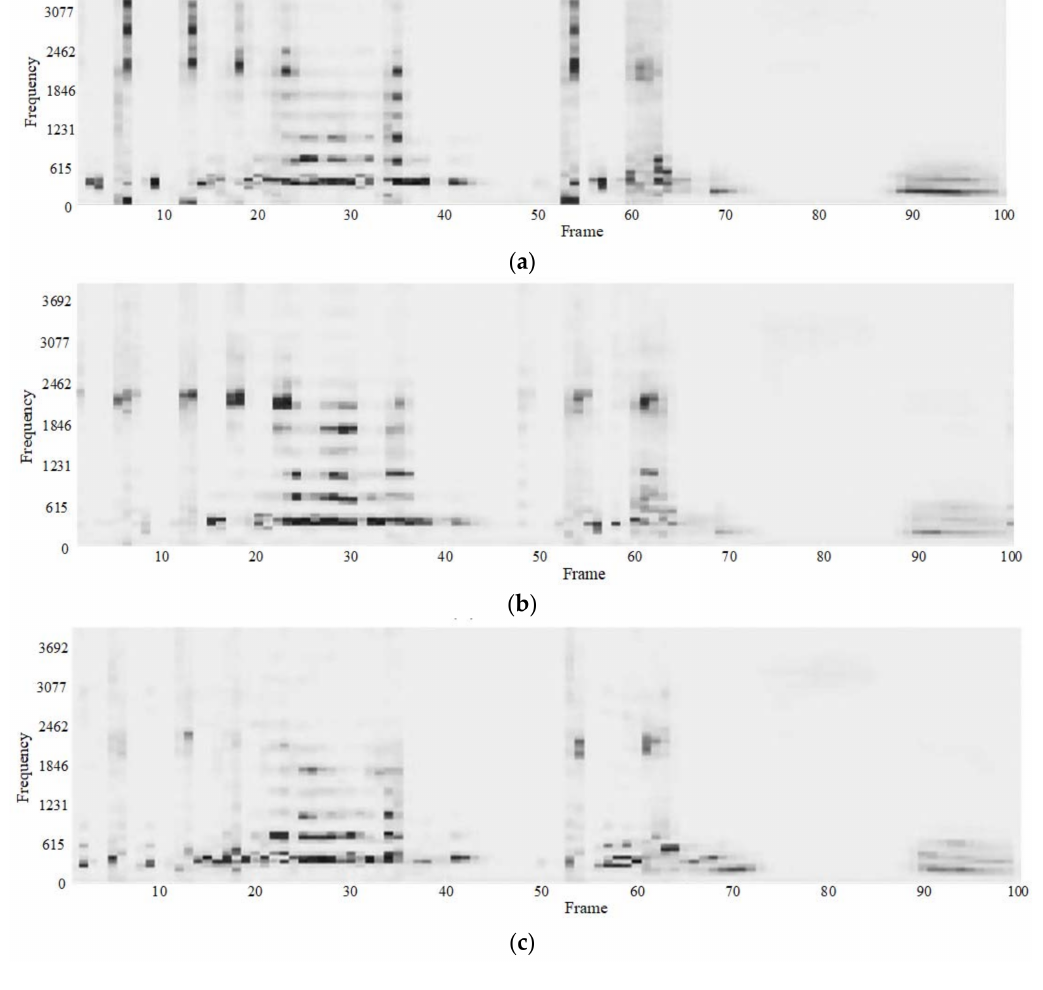
Figure 16. Spectrograms of recovered speech signal by using different numbers of iterations of DNN ( a ) 100 iterations ( b ) 200 iterations( c ) 500